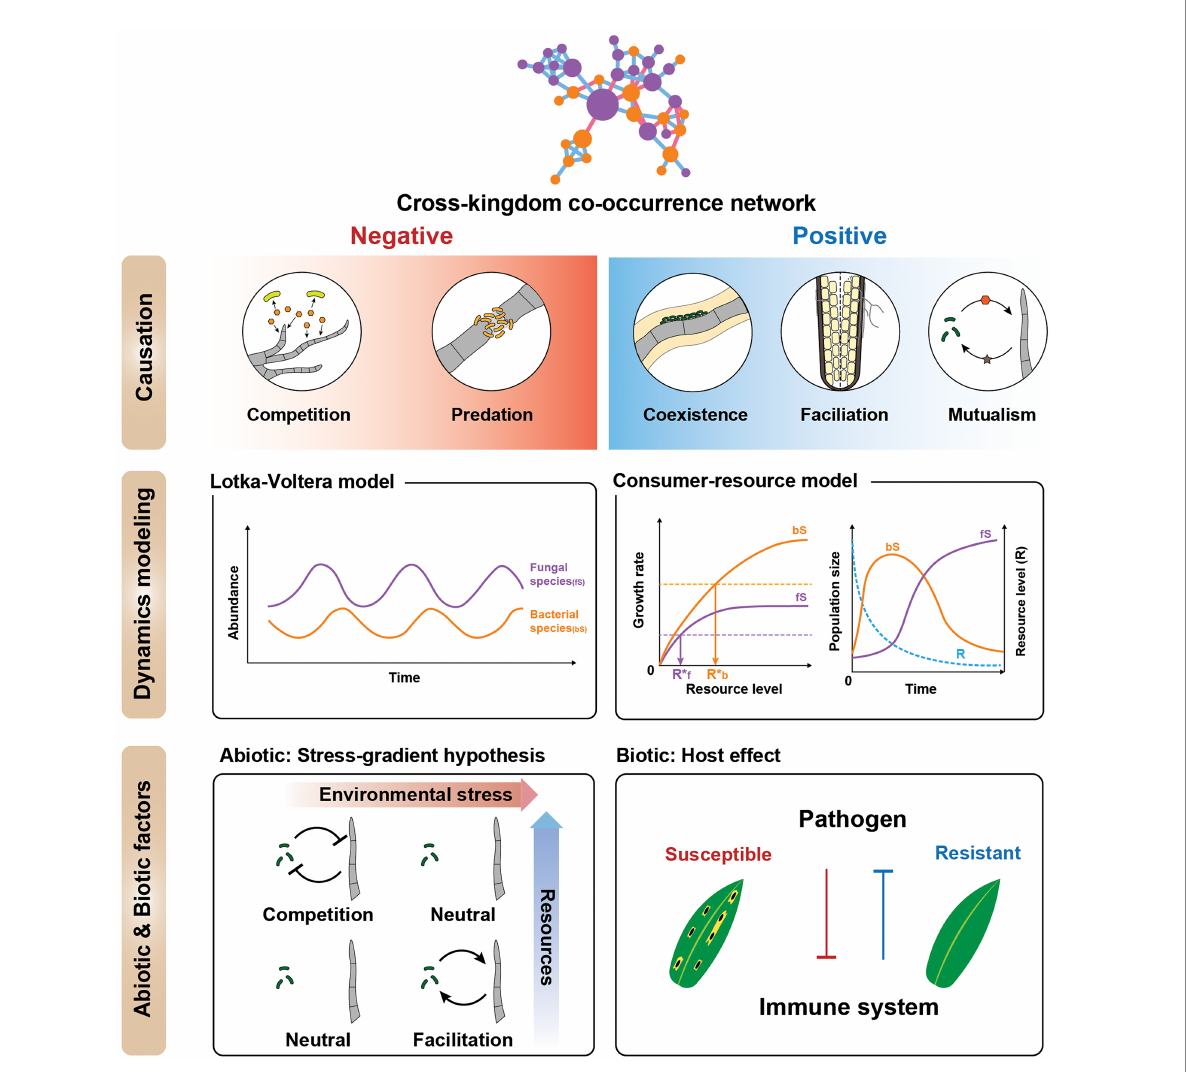
FIGURE 3 Ecological interpretations of cross-kingdom co-occurrence networks. (Top) Cartoon illustrating ways to interpret individual negative and positive fungal-bacterial edges. Negative interactions include competition and predator–prey relationships, whereas positive interactions are cooperative, such as coexistence, facilitation, and mutualism. All positive and negative correlations are not cooperation and competition, respectively. (Middle) Dynamical modeling of co-occurrence networks using generalized Lotka-Volterra (gLV) and consumer-resource models. The cartoon depicts species dynamics related to the gLV and consumer-resource model, respectively (only for illustration purposes). These models can be used to supplement the network to elucidate the mechanism of the interactions. (Bottom) Effects of abiotic and biotic factors on cross-kingdom networks. To investigate cross-kingdom interactions in natural microbial communities, it is important to treat microbial interactions as variables dependent on the magnitude of stress, space, time (abiotic factors), and host (biotic factor). ( Left ) Stress gradient hypothesis—the relative importance of competitive vs. facilitative interactions varies along the environmental harshness gradient. Another consideration is the host effect (biotic factor). ( Right ) The host immune system mediates the interaction between the bacterial and fungal communities. The biotic factors influencing the microbial community can be affected by host plant pathogen susceptibility or